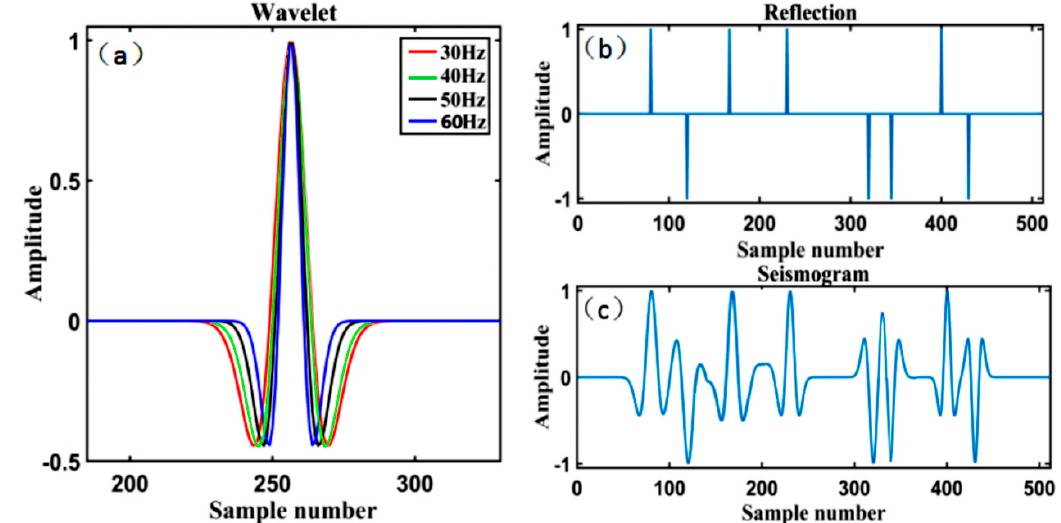
Figure 6. ( a ) Zero-phase Ricker wavelets of frequencies 30, 40, and 50 Hz. ( b ) Noise-free seismic channel containing 512 sampling points and six reflection spikes. ( c ) Synthetic seismogram.